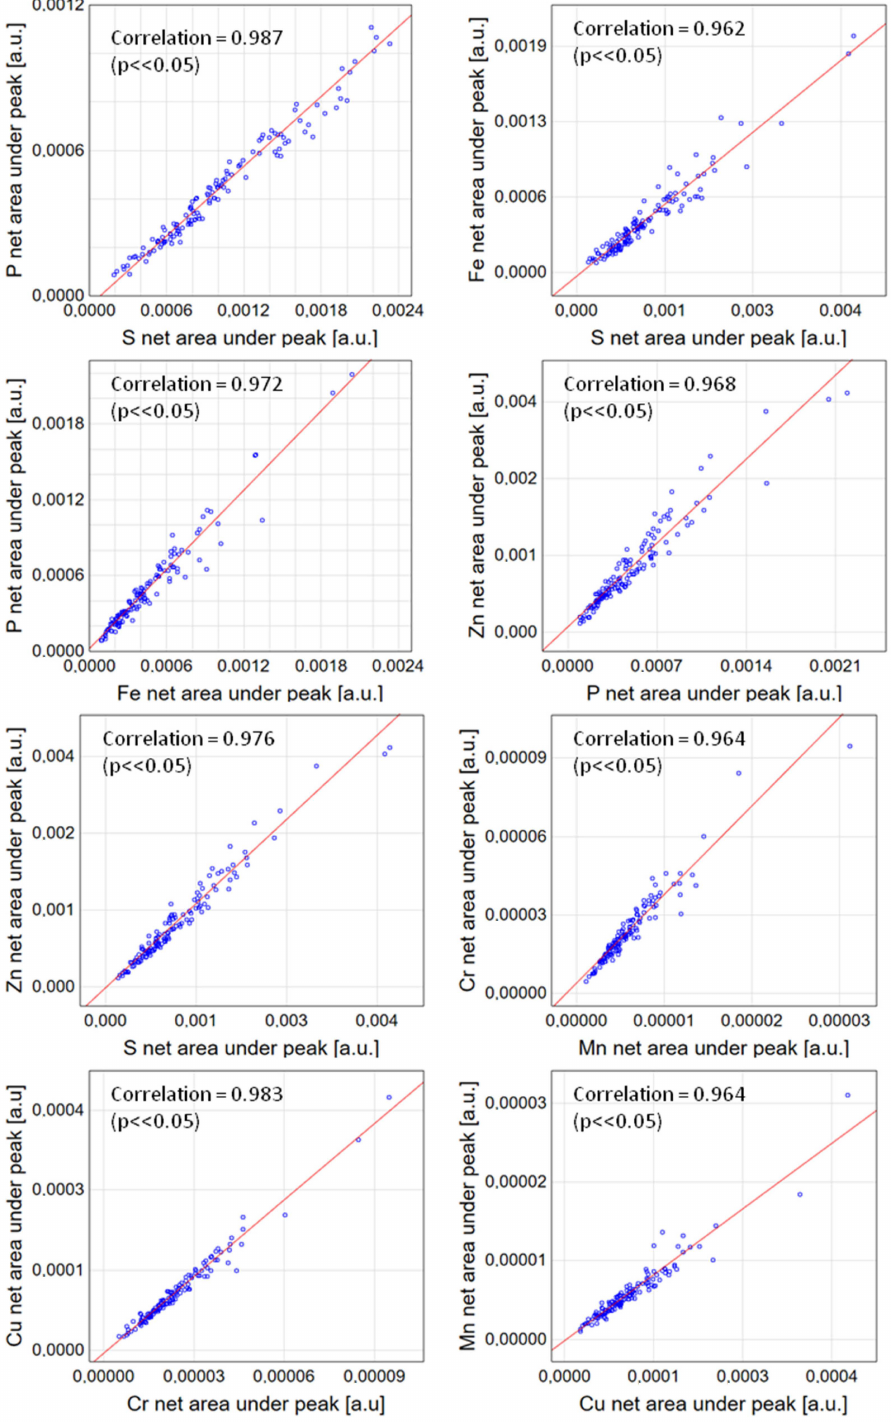
Figure 2. Correlation graphs for elements with the strongest dependence—correlation coefficient >